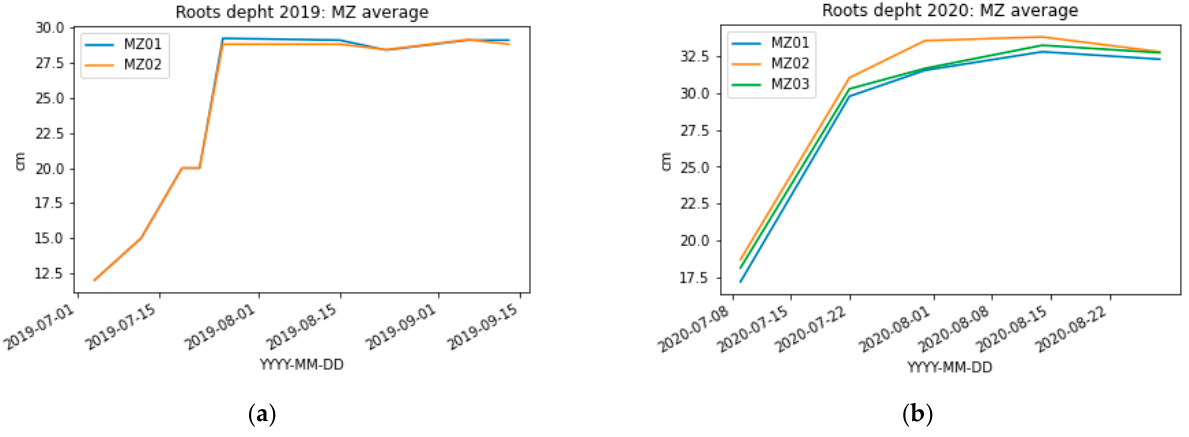
Figure 3. Average of root depth evolution (in cm) by MZ obtained in 2019 ( a ) and 2020 ( b ) growing seasons.